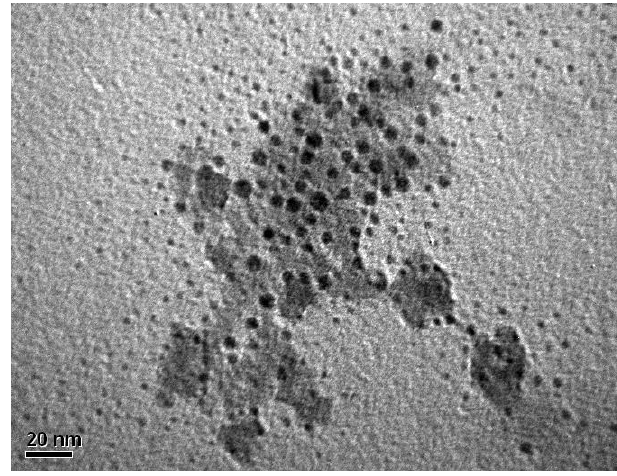
Figure 1. Transmission electron microscope image of copper nanoparticles used in this study.